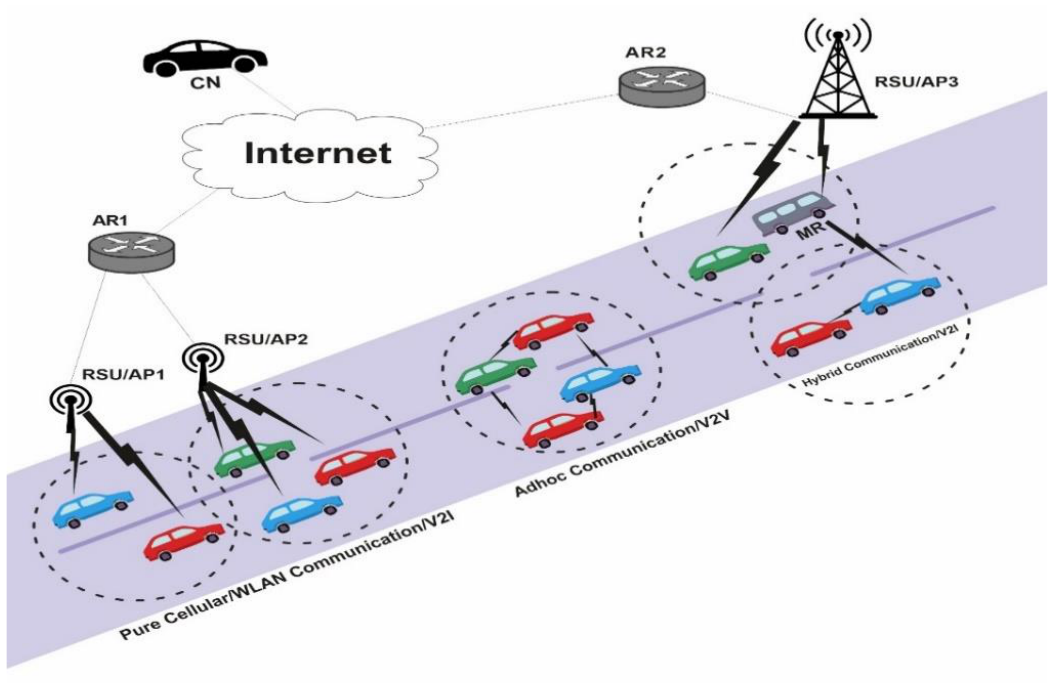
Figure 1. VANET Communication